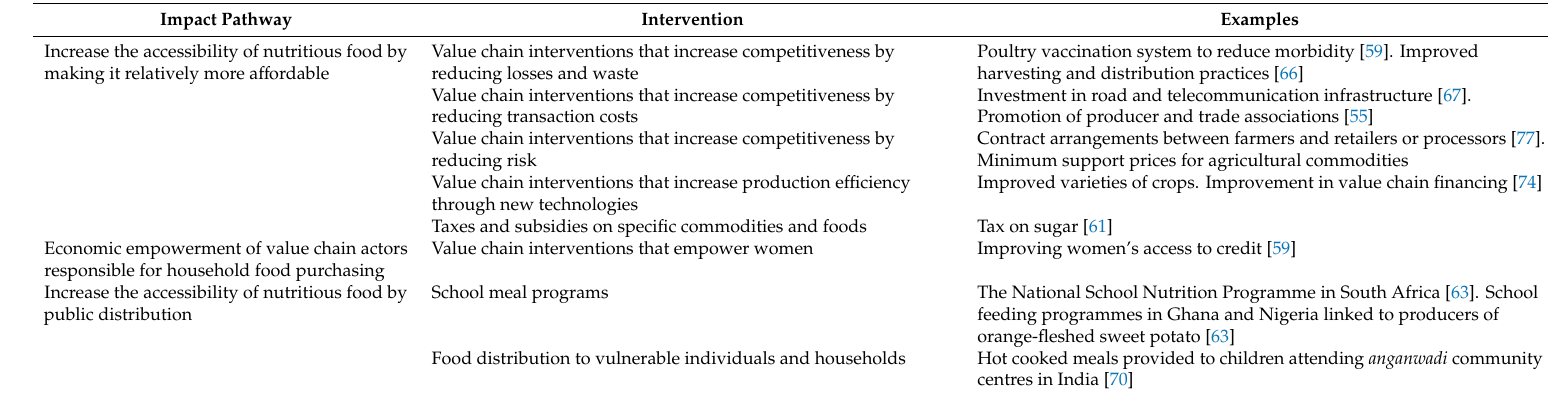
Table 3. Summary of value chain interventions with potential to improve diet quality through increasing the accessibility of nutritious food in the local food